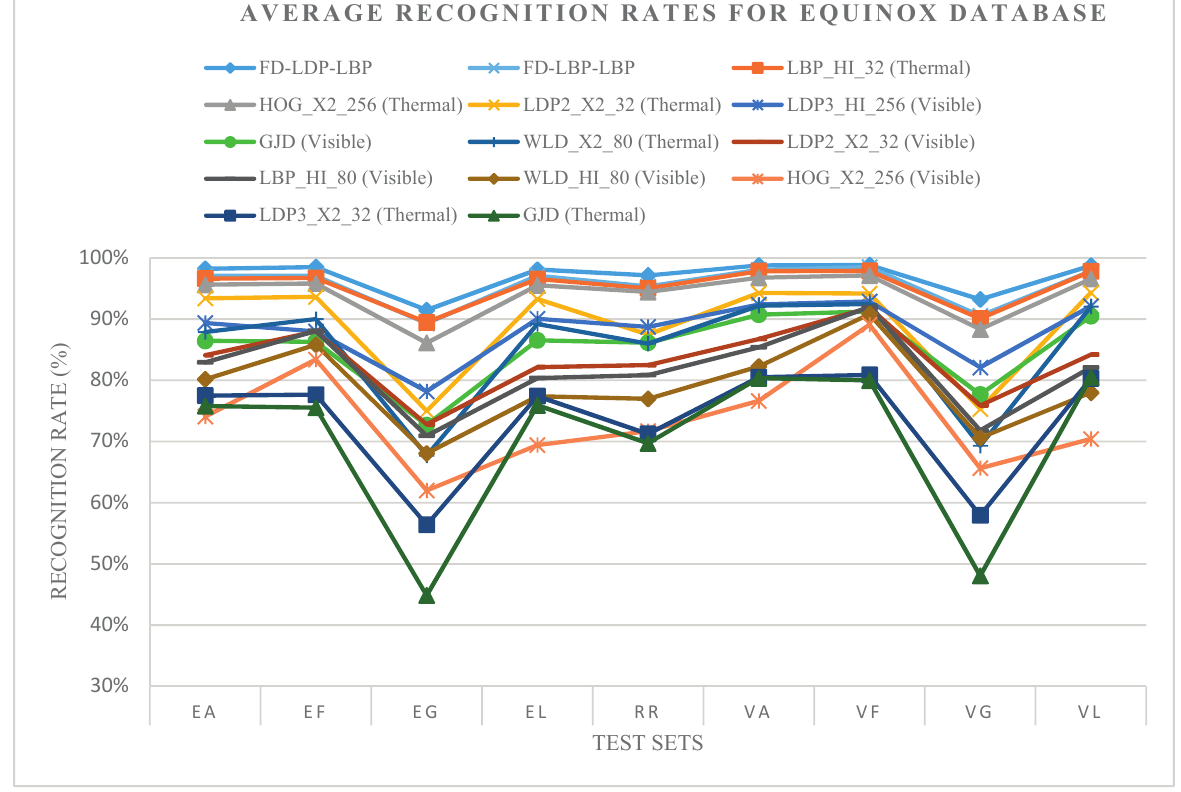
Figure 6. Average recognition rates for the Equinox database. Different test sets against the entire gallery sets.